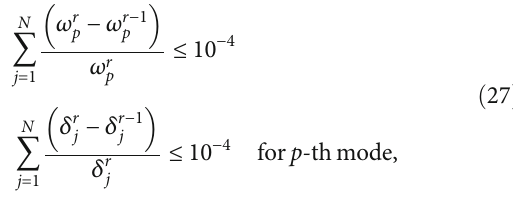
Table 1: Nonlinear central de fl ection w